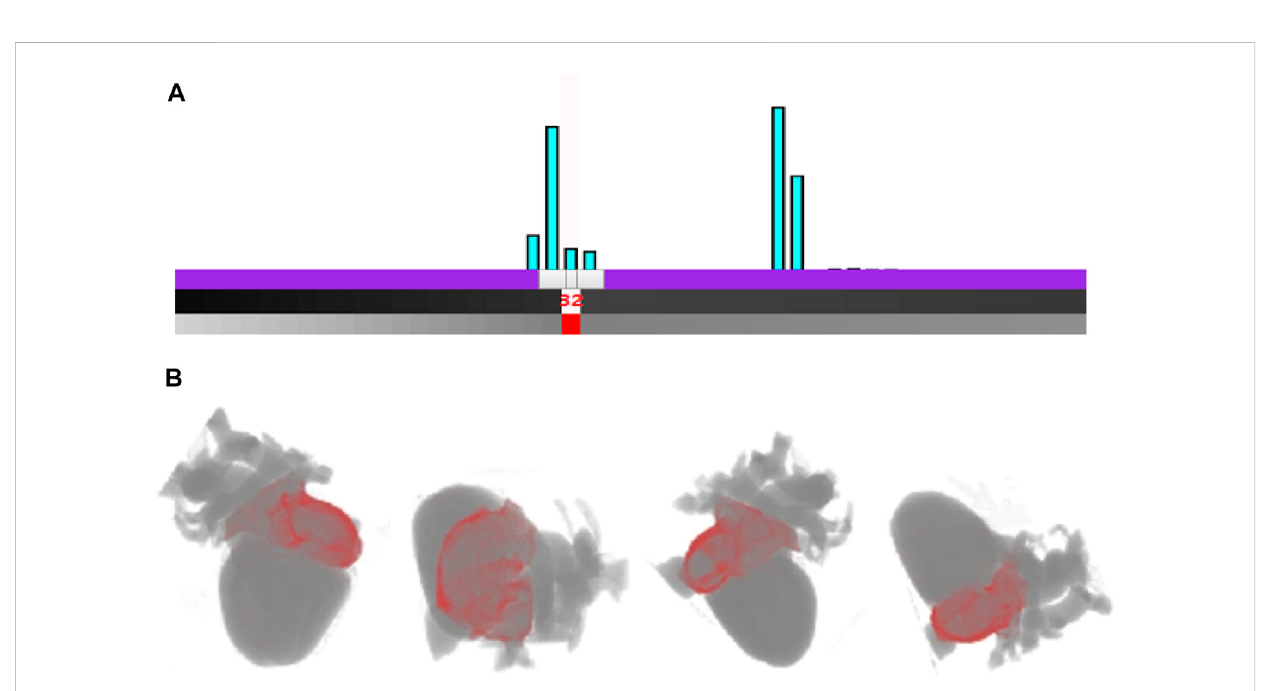
FIGURE 6 Rendering of the right atrium based on the interactive histogram (A) . The interaction with cardiac modality histogram by adding control point and setting the color for the right atrium (B) . Rendering result of the right atrium outer wall of arterial vessels from different